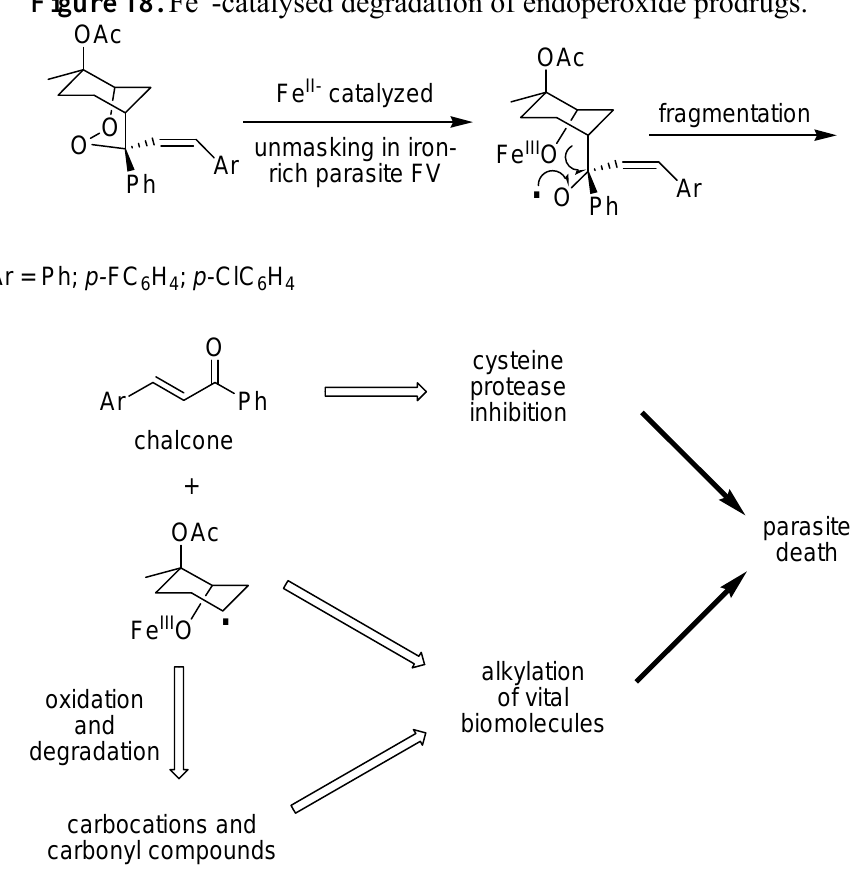
Figure 18. Fe II -catalysed degradation of endoperoxide